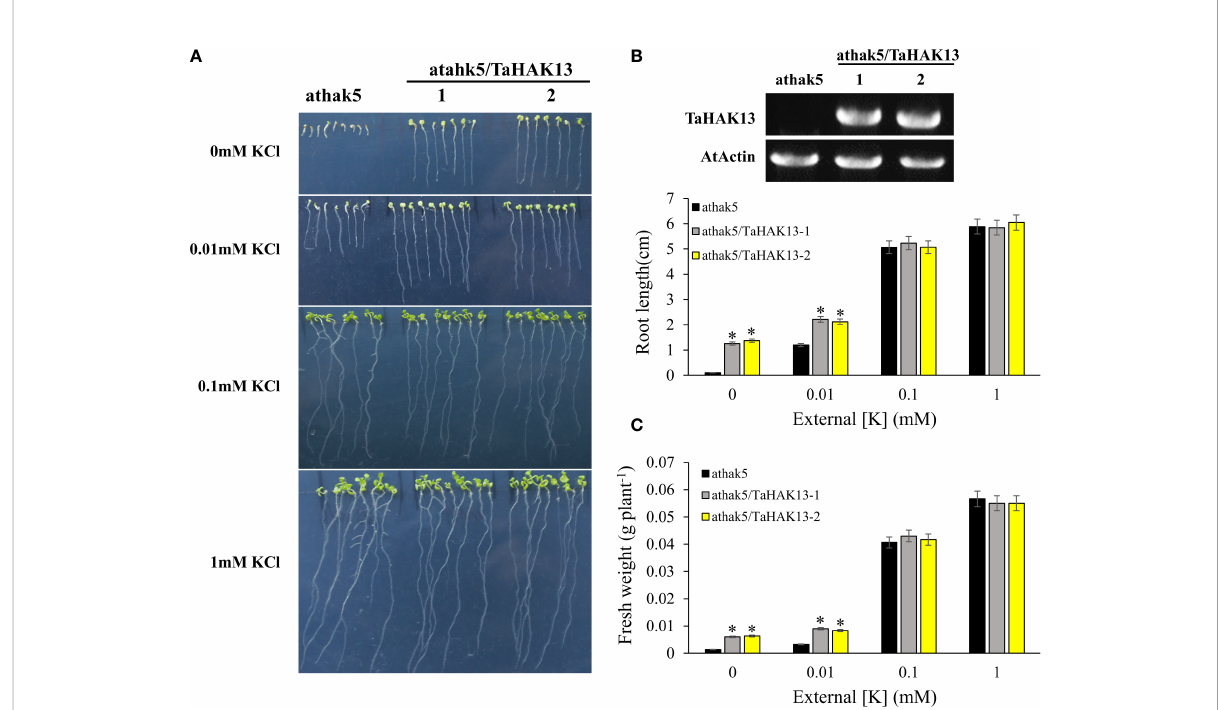
FIGURE 6 The expression of TaHAK13 rescued the sensitive phenotype of Arabidopsis mutant athak5 under low potassium condition. (A) The athak5 mutant and TaHAK13 transgenic lines ( athak5/TaHAK13 ) were grown on MS media with different K + concentrations for 10 d. (B) The expression of TaHAK13 in athak5 and the transgenic lines ( athak5/TaHAK13 ) was analyzed using RT-PCR. (C) The root length in each bar represents the average root length of 20 seedlings from three independent experiments. (D) The plant fresh weight in each bar represents the average fresh weight of 20 seedlings from three independent experiments. The Student t-test (*p<0.05) was used to analyze the statistical signi fi